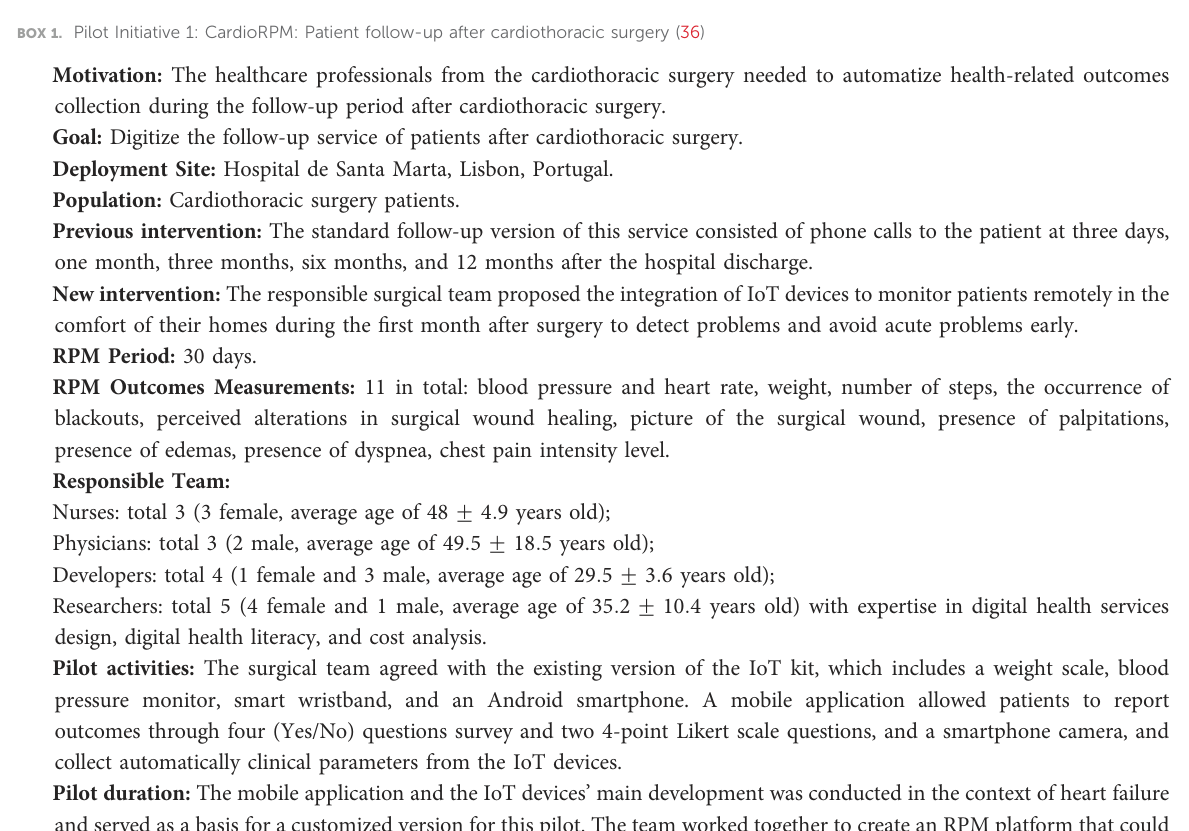
BOX 1. Pilot Initiative 1: CardioRPM: Patient follow-up after cardiothoracic surgery (36) Motivation: The healthcare professionals from the cardiothoracic surgery needed to automatize health-related outcomes collection during the follow-up period after cardiothoracic